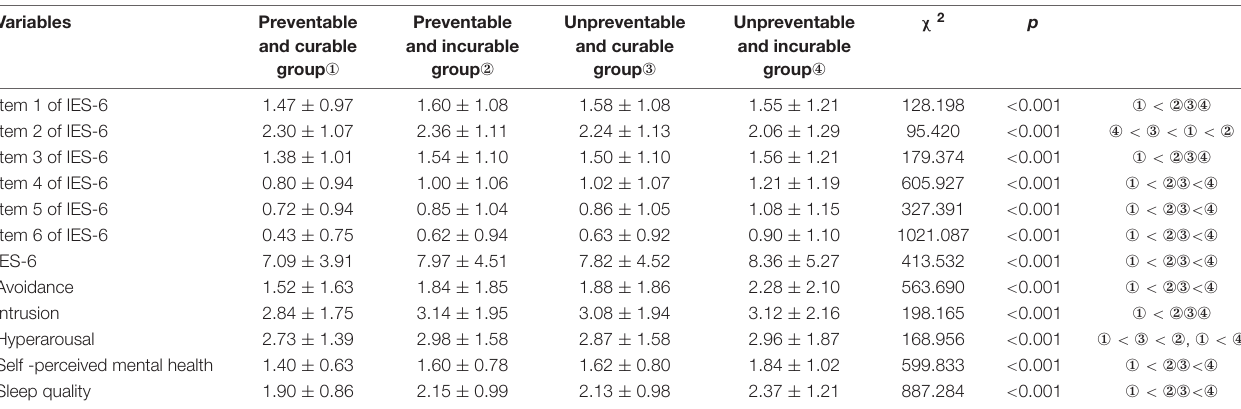
TABLE 2 | Comparisons of psychological